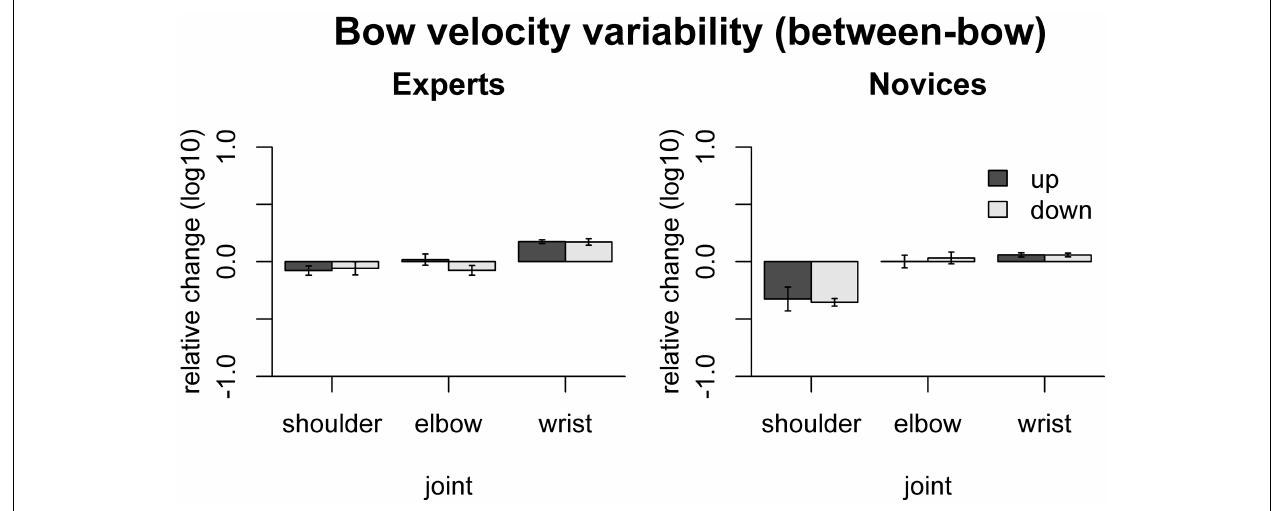
FIGURE 5 | Results of the freezing analysis for between-bow variability of bow velocity (central 80% of the bow movement). Error bars indicate SE across participants.